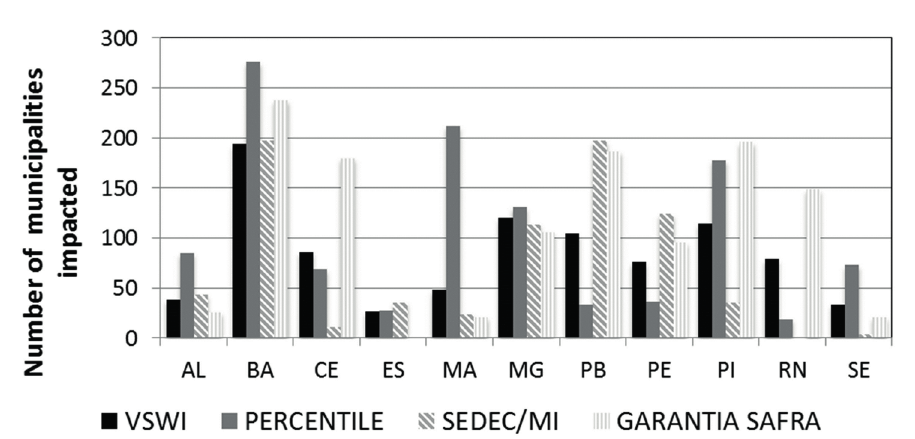
Figure 7 - Municipalities affected by drought according to the methodology proposed (VSWI index and precipitation percentile) and those duly recognized by the National Integration Ministry and the Crop Guarantee Program.